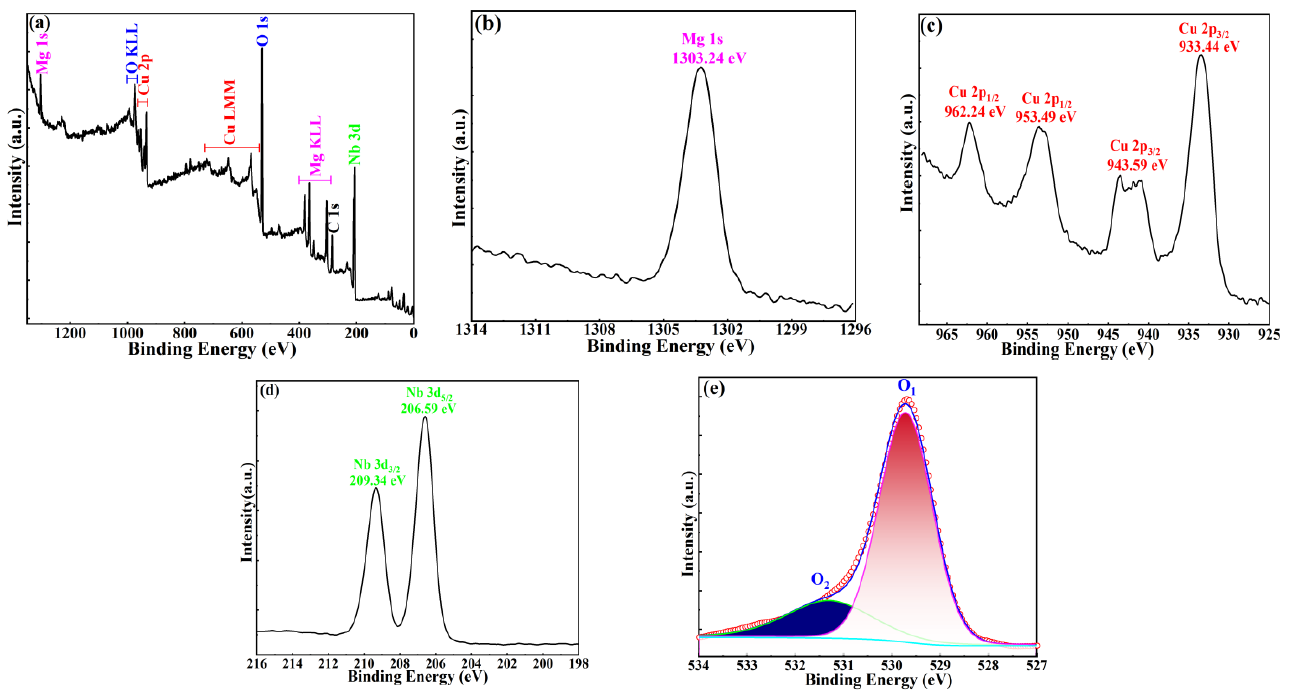
Figure 5. XPS spectra of MgCu 2 Nb 2 O 8 ceramics sintered at 925 °C: ( a ) the survey spectrum, ( b ) Mg 1s, ( c ) Cu 2p, ( d ) Nb 3d, and ( e ) O 1s.